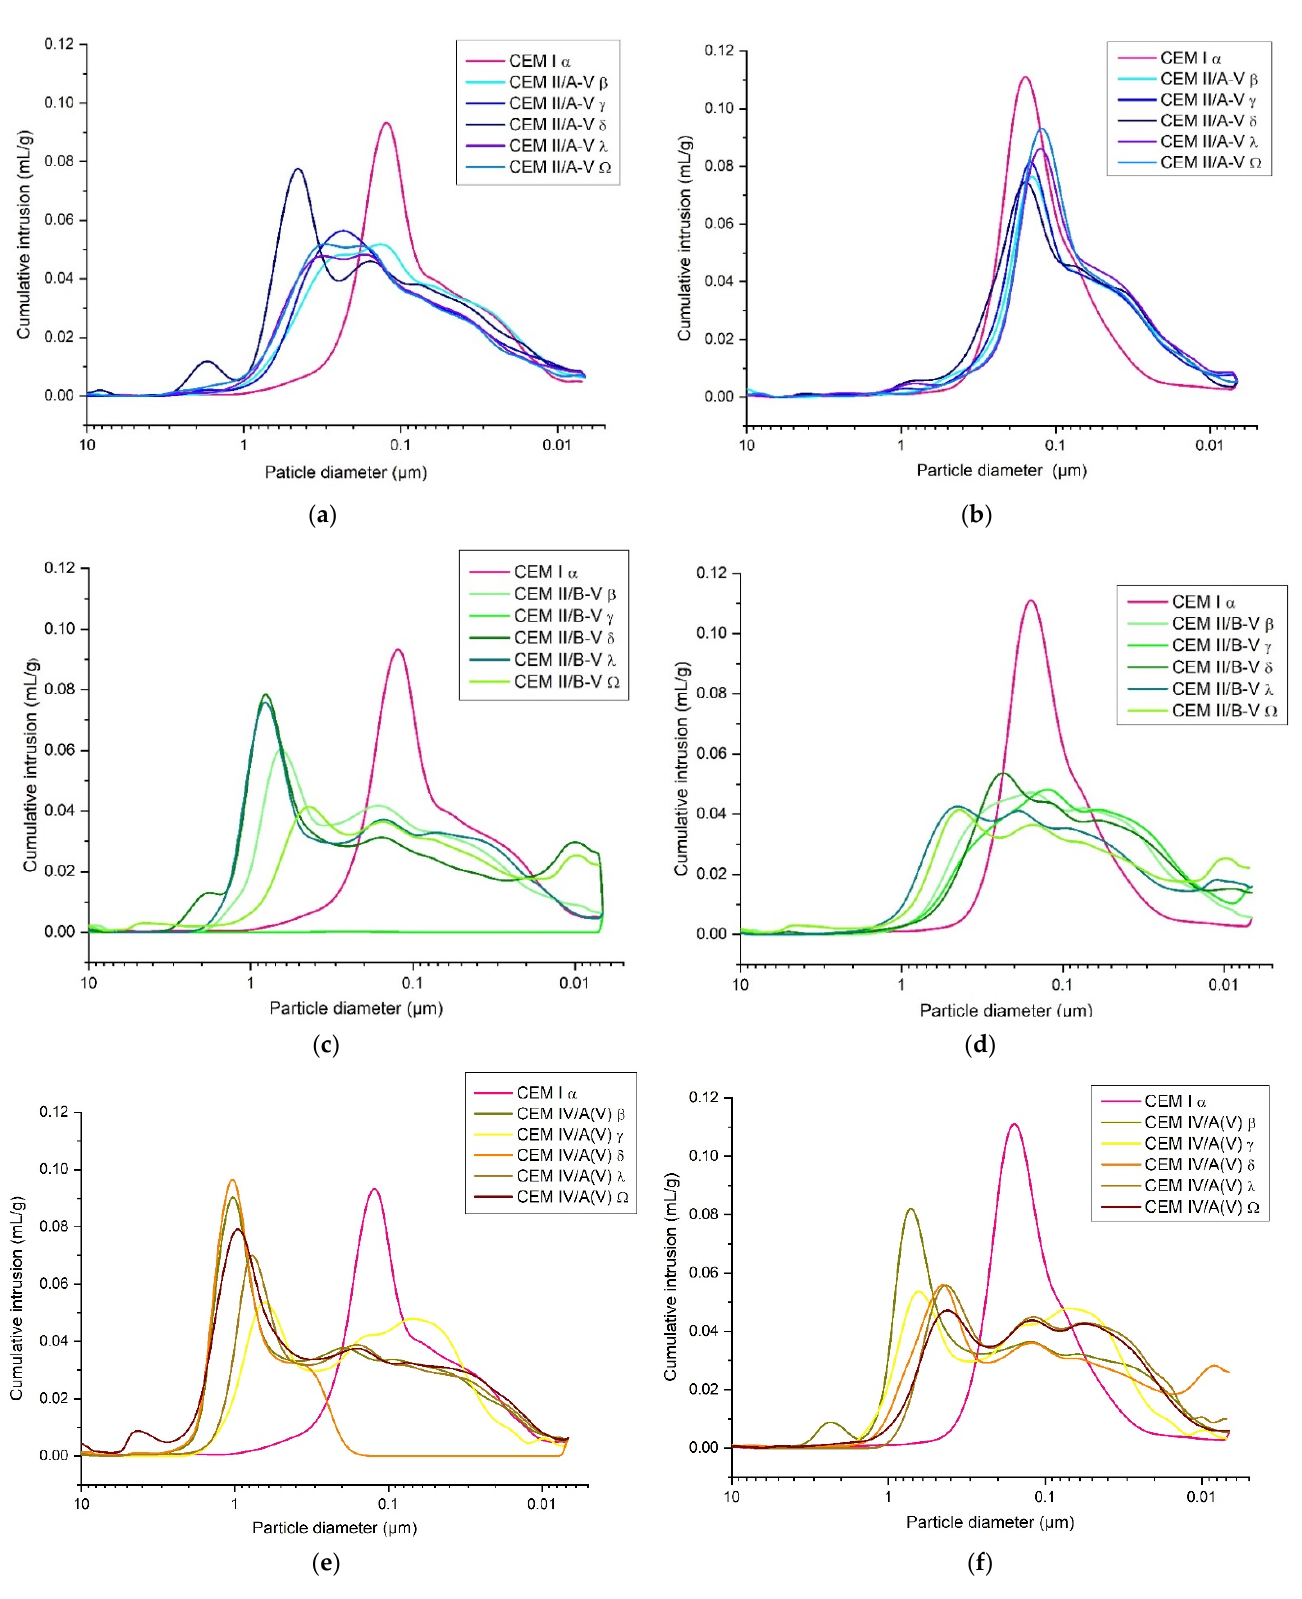
Figure 11. Mercury intrusion porosimetry (MIP) of mortars: ( a ) CEM I and CEM II/A-V at 7 days; ( b ) CEM I and CEM II/A-V at 28 days; ( c ) CEM I and CEM II/B-V at 7 days; ( d ) CEM I and CEM II/B-V at 28 days; ( e ) CEM I and CEM IV/A (V) at 7 days; and ( f ) CEM I and CEM IV/A (V) at 28 days. CEM II/A-V mortars at 7 days were more porous than the reference mortar (CEM I)